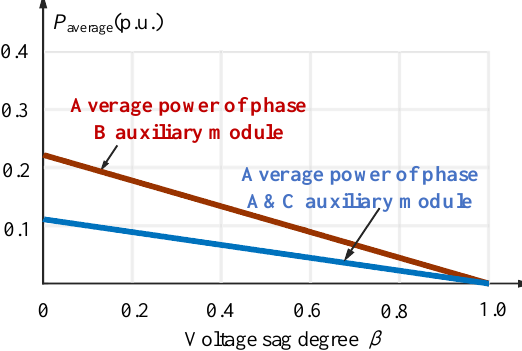
Figure 7. Output power of the auxiliary module.